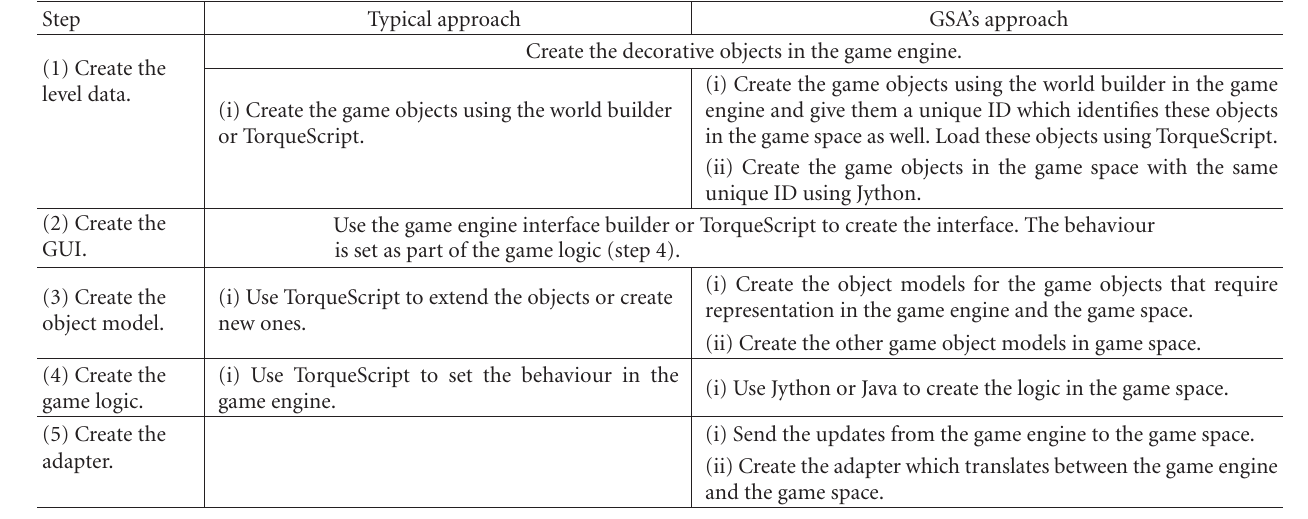
Table 1: Comparing a typical game development approach to GSA’s